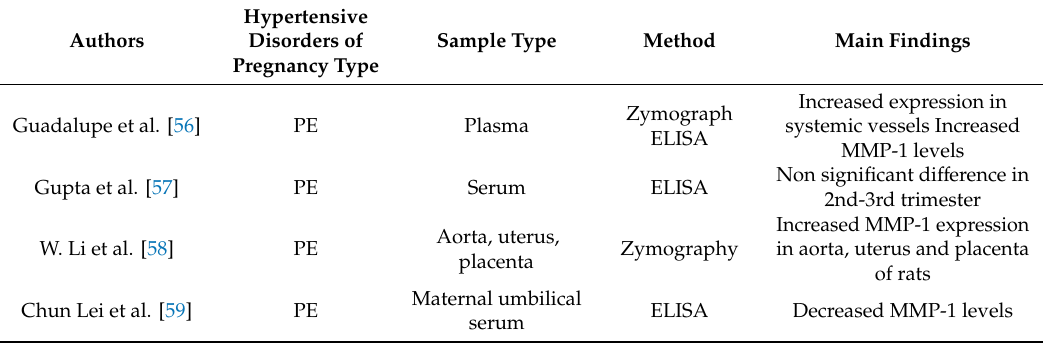
Table 1. Levels of matrix metalloproteinase 1 (MMP-1) in samples of patients with hypertensive disorders of